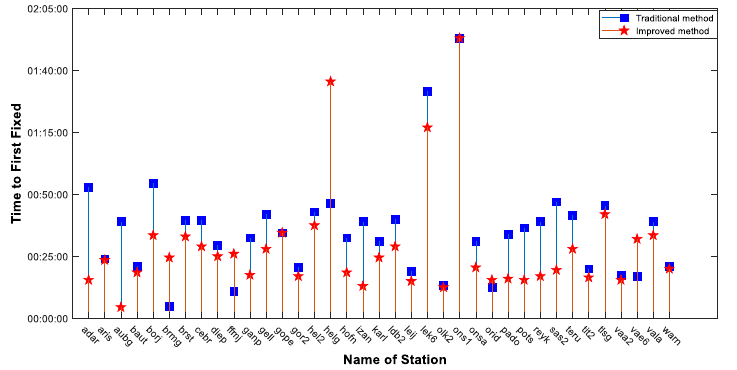
Figure 12. TTFF of 37 stations by static model.